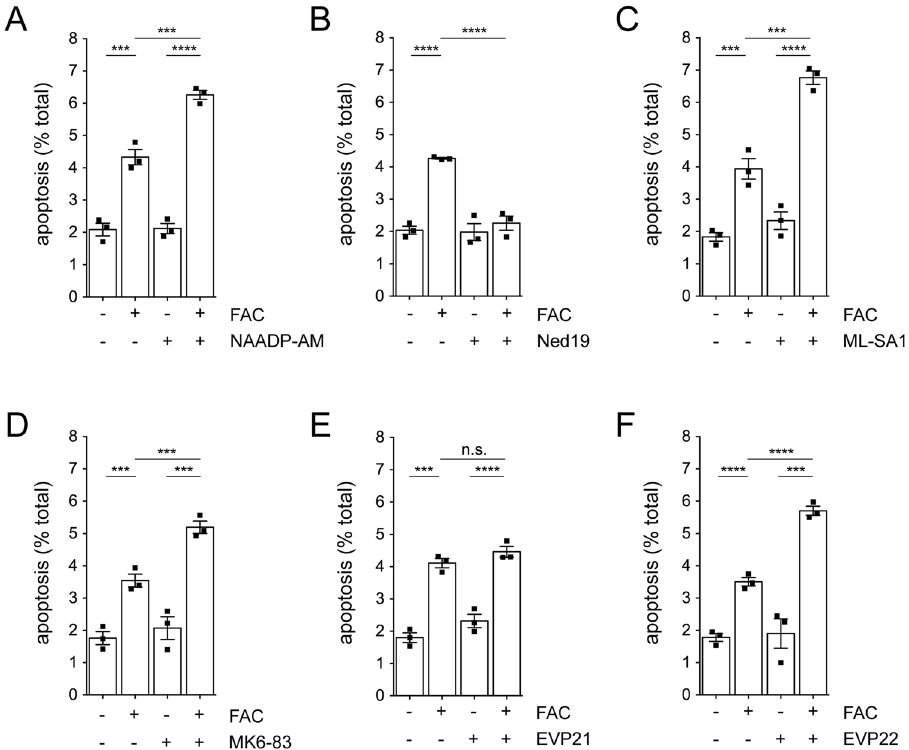
Fig. 2 FAC-mediated apoptosis is potentiated by TRPML1 and TRPML2 activators. A HEK293T cells were treated with or without FAC (50 μ M, 48 h) and with or without 100 nM NAADP-AM for the last 12 h as indicated. B As in A , but with or without Ned19 (1 μ M, 12 h). C As